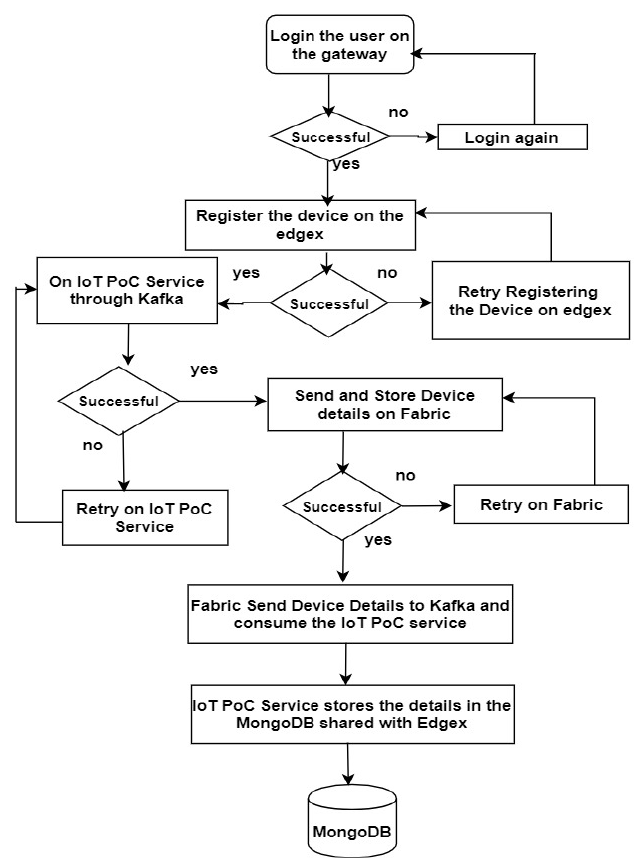
Figure 6. Flowchart showing steps taken for the implementation.